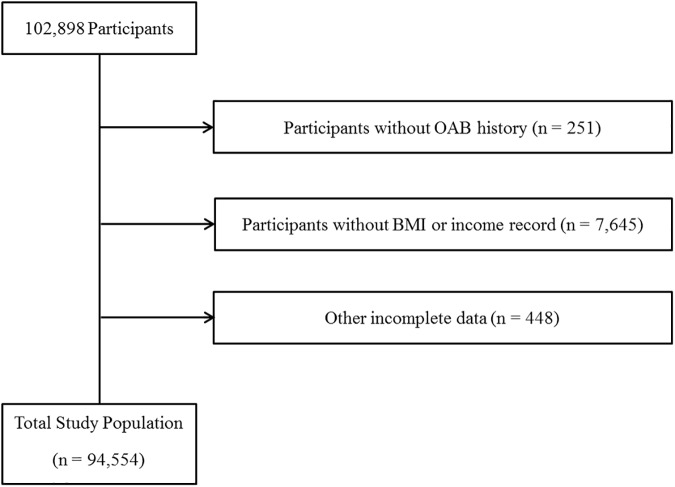
A schematic illustration of participant selection in the present study.Among a total of 102,898 participants, participants without OAB history (n = 251), BMI or income record (7,645), and other incomplete data (448) were excluded. The data for the 94,554 participants from whom complete data were obtained were analyzed.